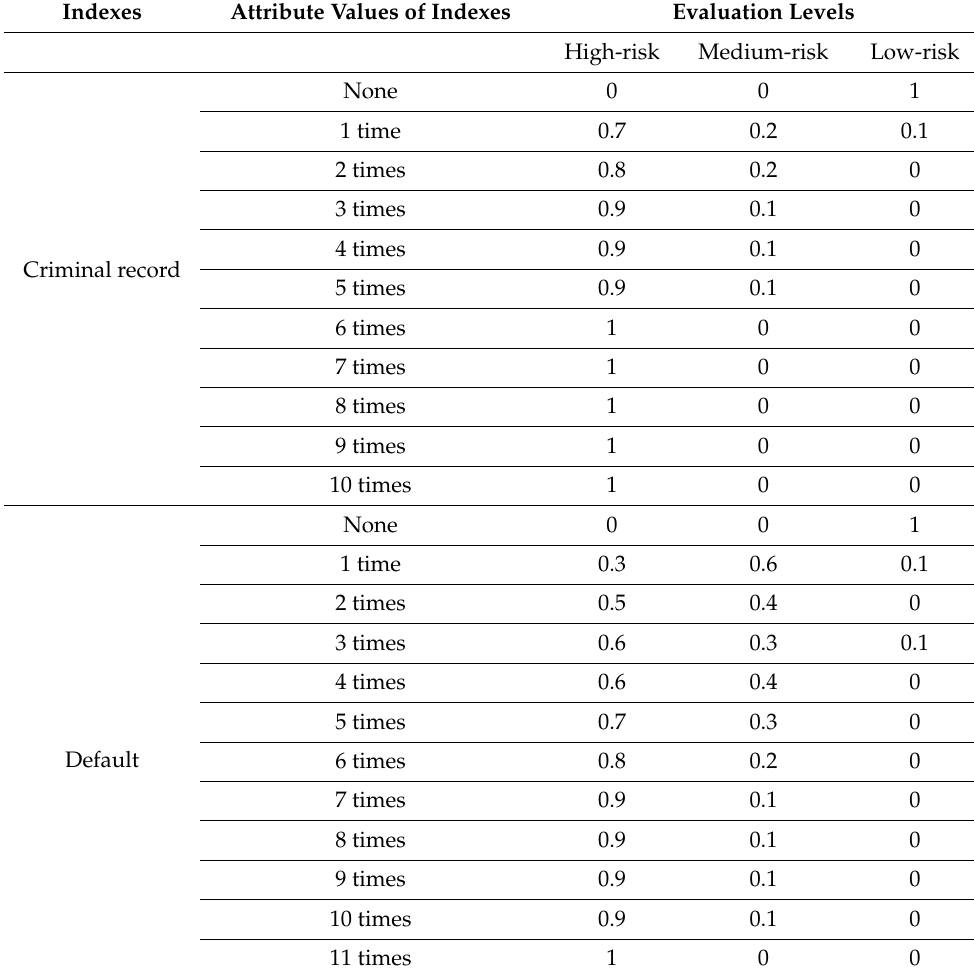
Table A15. Single factor evaluation of personal conduct